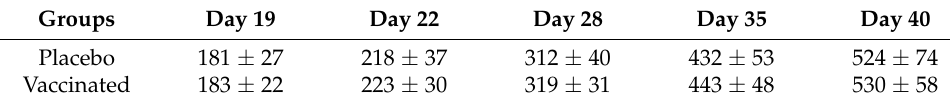
Table 2. Body weights (mean ± SD in g) of chicken groups during the trial.